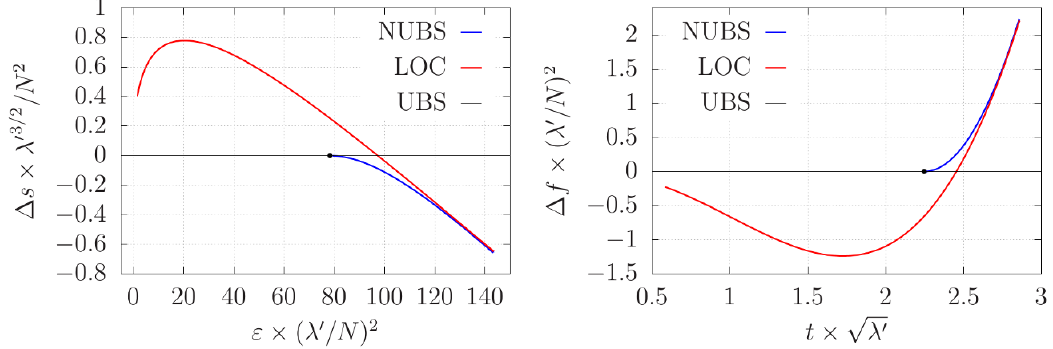
Figure 12 . Phase diagram in the microcanonical ensemble (left) and canonical ensemble (right), of UBS, NUBS and LOC with D0-charge in the decoupling limit. The GL threshold point " GL or t GL is indicated with a black solid